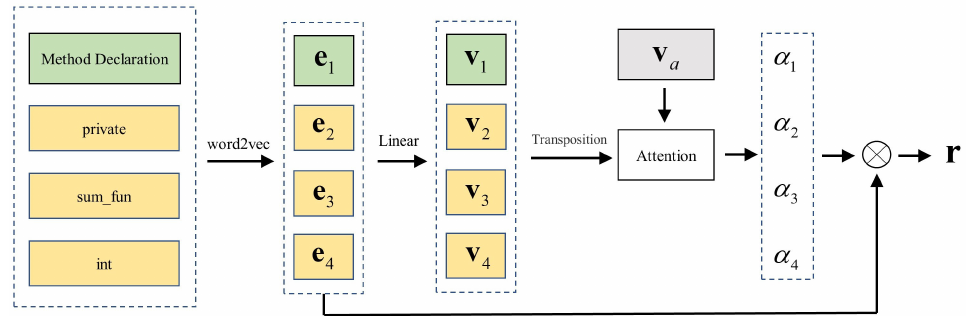
Figure 4. The generation process of group representation r